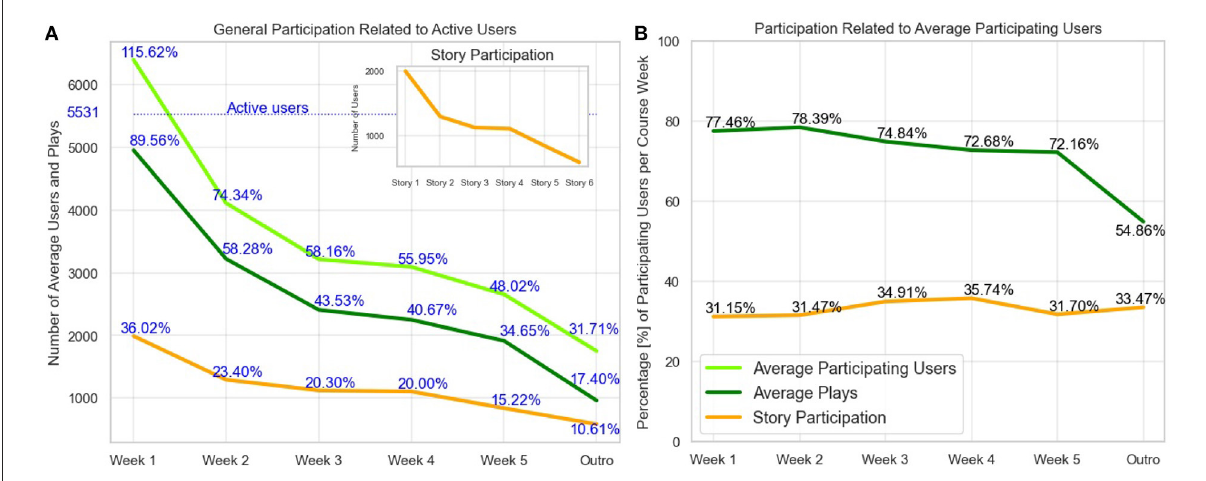
FIGURE3 Left (A) : Average video plays, average participating users (not limited to active users but those who visited at least one course item), and story quiz participation per course week. The absolute numbers are set in relation to the active users identified at the course end (5.531), indicated in blue. As participating users did not necessarily achieve any course points, the percentage can be above 100%. Right (B) : Average videos plays and story quiz submissions related to the average number of participating users per course week.